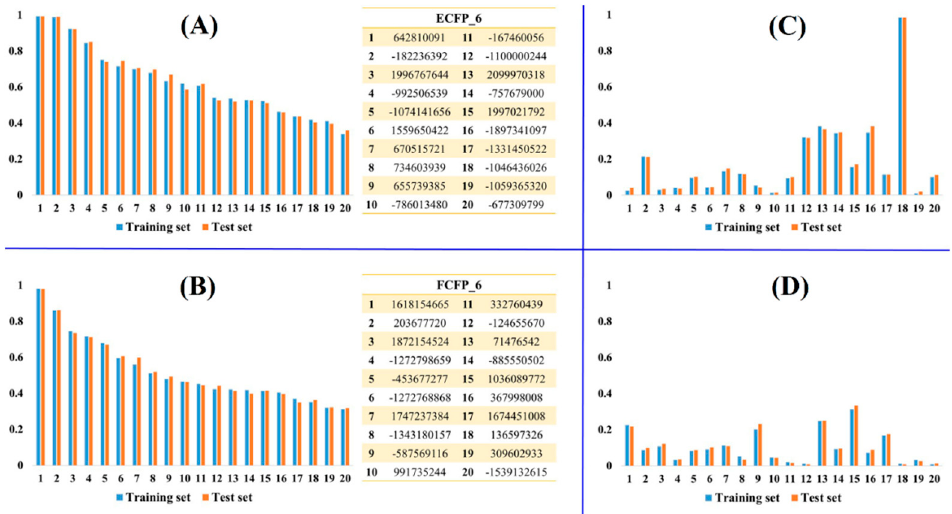
Figure 2. Fingerprint frequency of the training and test sets of hERG blockers. X-axis denotes fingerprint identifier whereas Y-axis denotes the fingerprint frequency. Representative integer type PP fingerprints: ( A ) ECFP_6 and ( B ) FCFP_6. Representative binary type chemistry development kit (CDK)